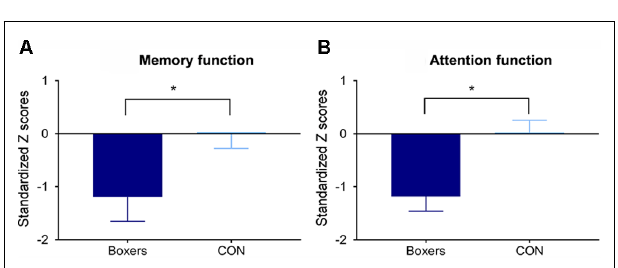
FIGURE 3 | Between-group difference in the memory and attention functions. Standardized Z scores of memory and attention function were calculated using the corresponding means and standard deviations (SDs) of the control group. Error bars indicate standard errors. The Boxers group showed poorer performance (A) in the memory domain ( z = − 2.01, permutation-adjusted P = 0.045) and (B) in the attention domain ( z = − 2.92, permutation-adjusted P = 0.006) compared to the CON group. ∗ Indicates P <